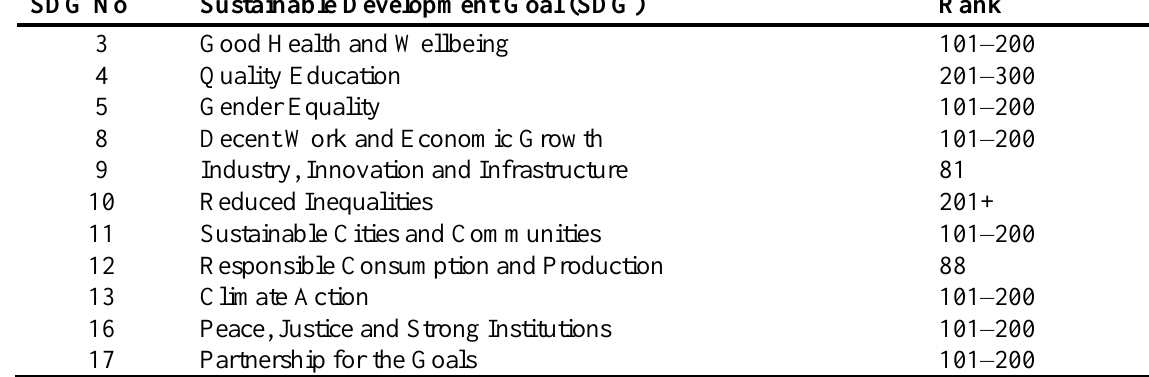
Table 1. Erciyes University SDG